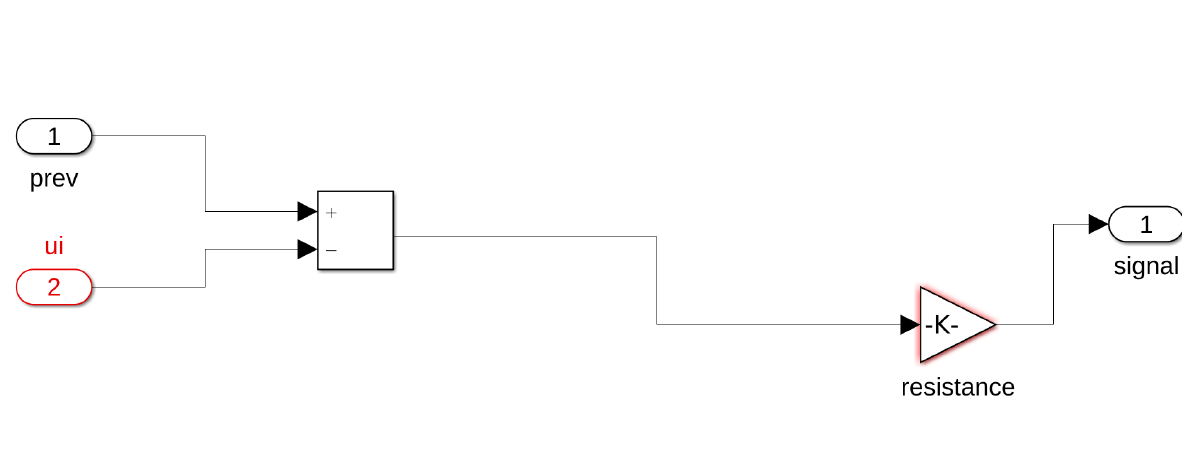
Figure A1. Example cell block Matlab Simulink.